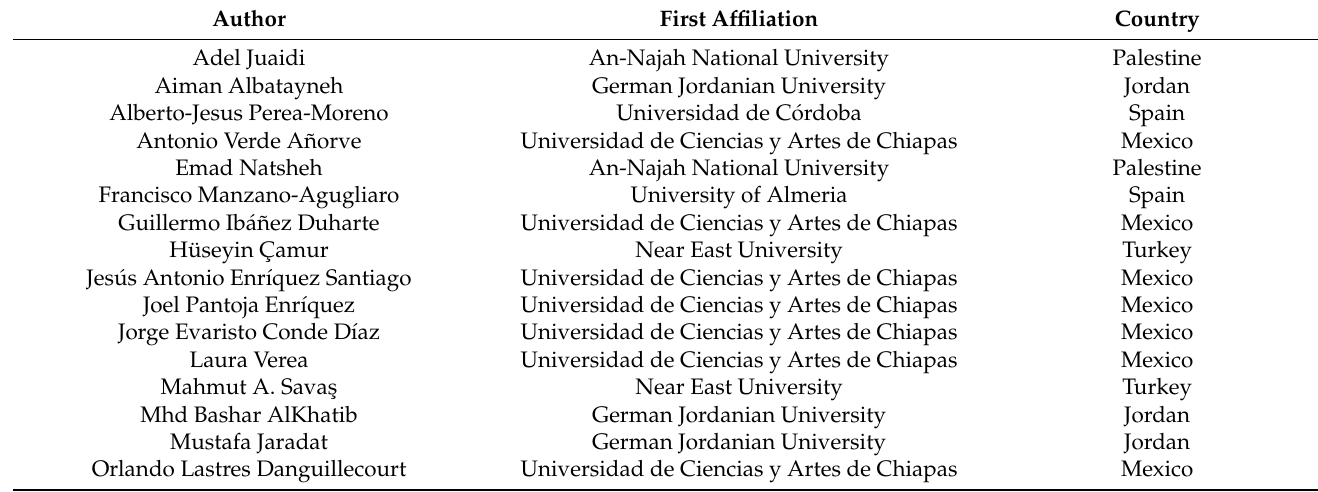
Table 2. Authors’